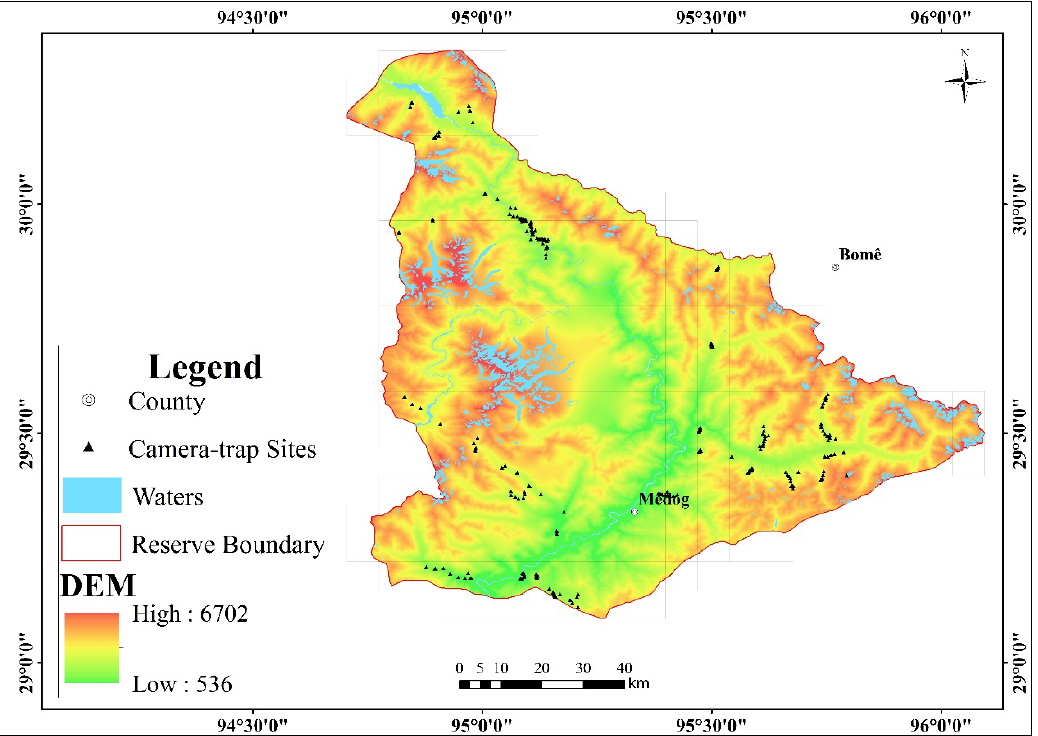
Figure 1. Study area and camera trap sites in the Yarlung Zangbo Grand Canyon National Nature Reserve, Tibet, from 2013 to 2021.